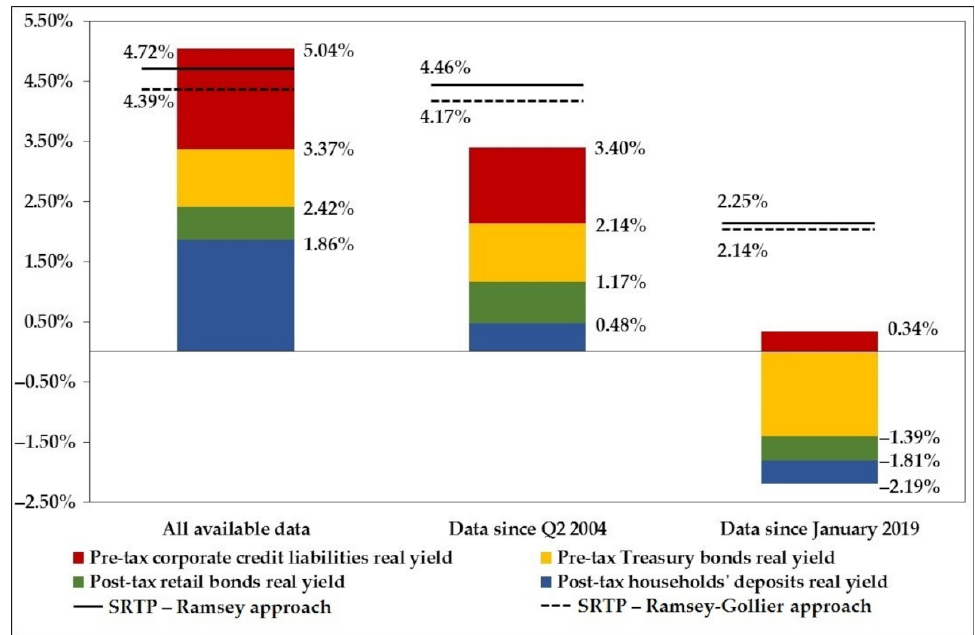
Figure 4. Estimates of Social Opportunity Cost and Social Rate of Time Preference.